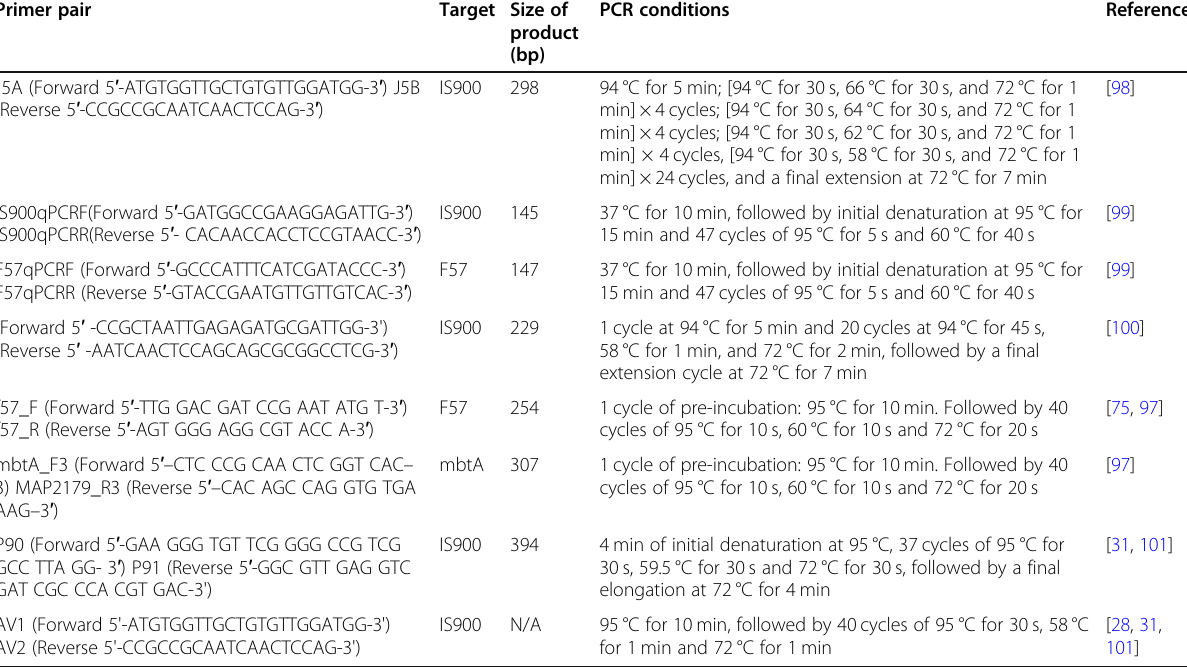
Table 1 Primer pairs, targets and conditions commonly used for MAP detection Primer